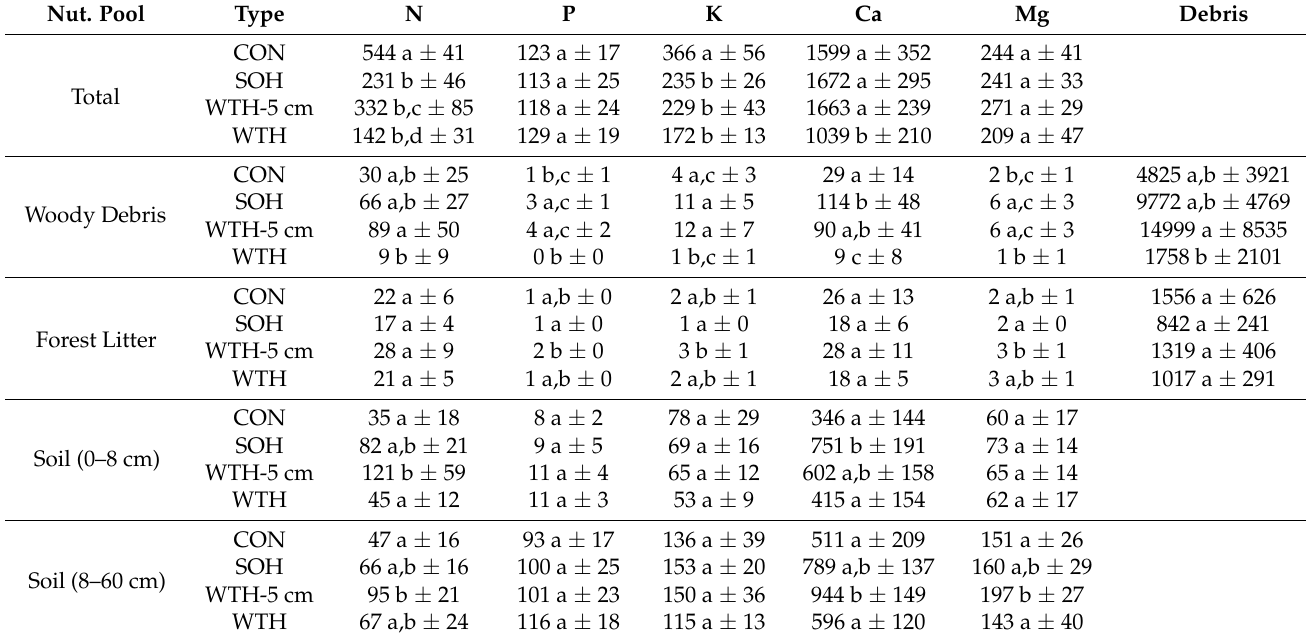
Table 2. Average kilograms per hectare and confidence intervals ( α = 0.05) of nutrient pools by harvest type (CON = control, SOH = stem-only harvest, WTH-5 cm = whole-tree harvest up to 5 cm, WTH = whole-tree harvest). Wilcoxon signed-rank test p -values by nutrient pool and element, showing significant differences across all elements for woody debris, litter Mg, and N and K for the total pools ( α = 0.05). Significant differences reported by differences in lower-case